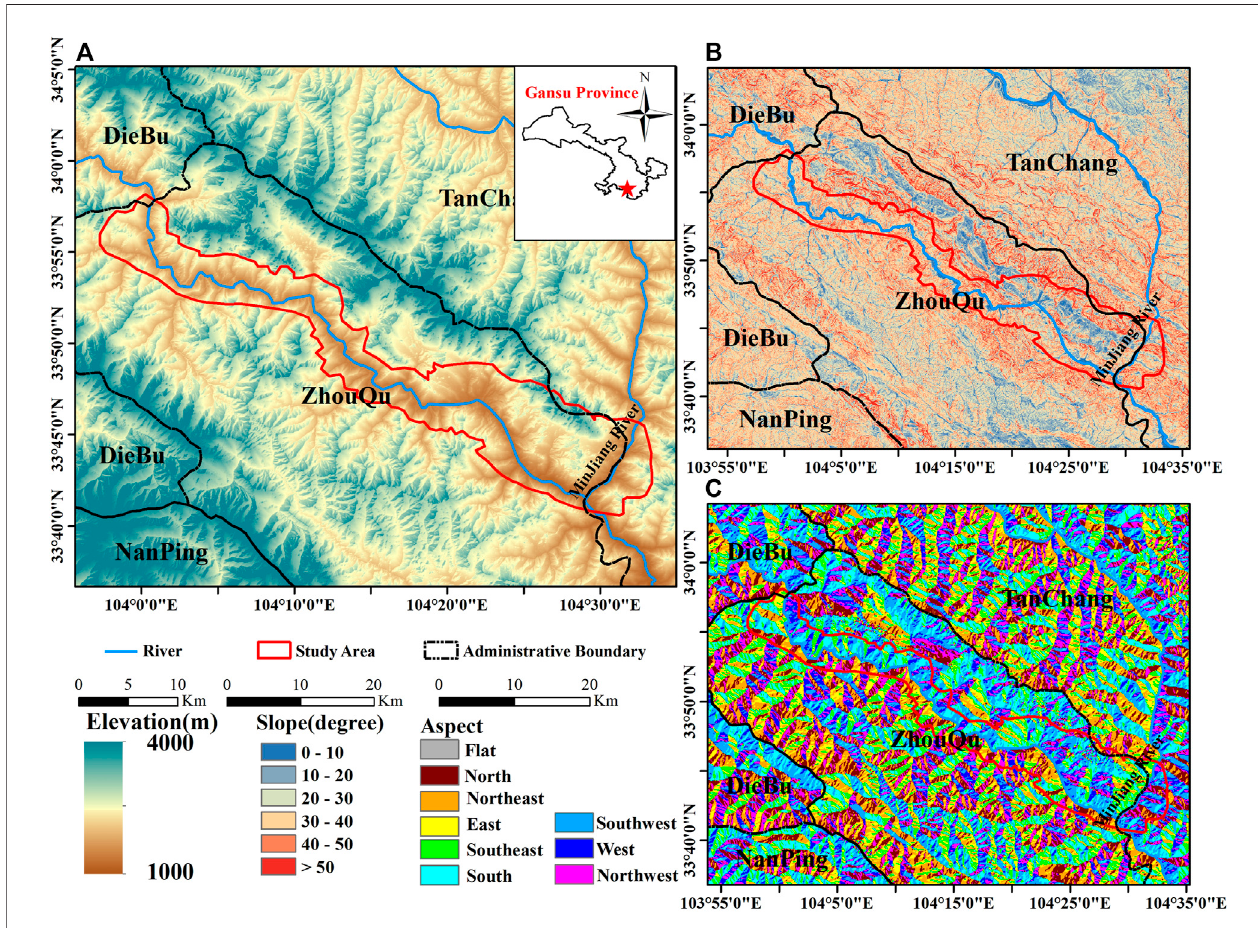
FIGURE 1 | Location map of the study area. (A) Elevation map. (B) Slope angle map. (C) Aspect map.